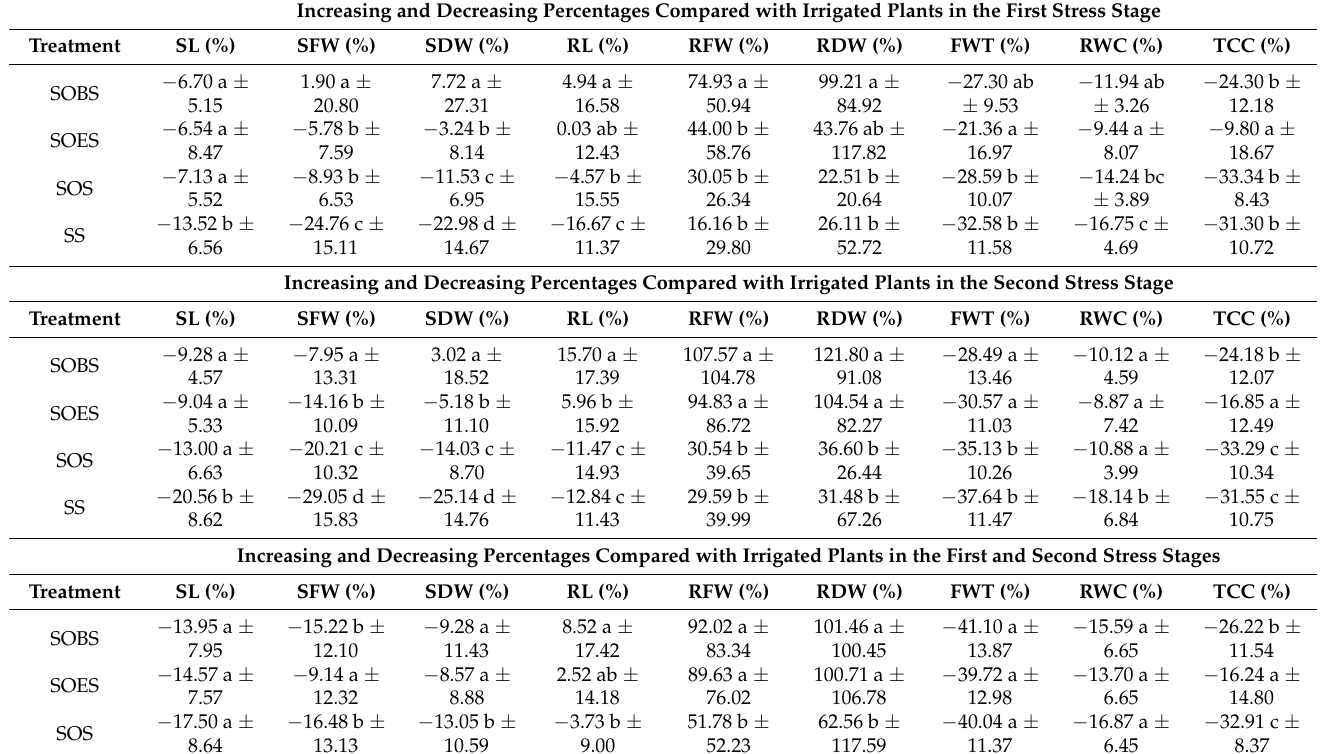
Table 1. Effect of oak leaf powder, oak leaf extract, and biofertilizer on the morpho-physiological characteristics of tomato plants at various stress stages. Positive and negative values signify increasing and declining,